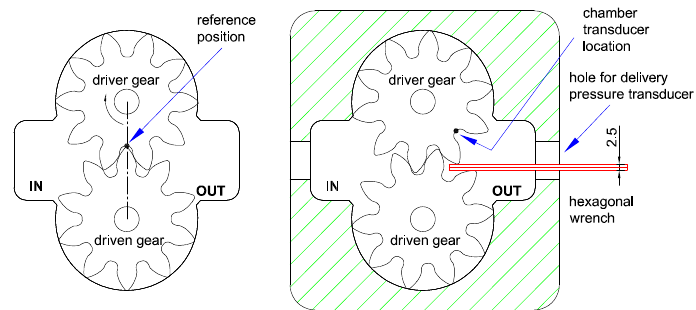
Figure 5. Reference position of the chamber in the simulation and method for determining a known angular position of the gears with respect to the reference signal of the encoder (marker).